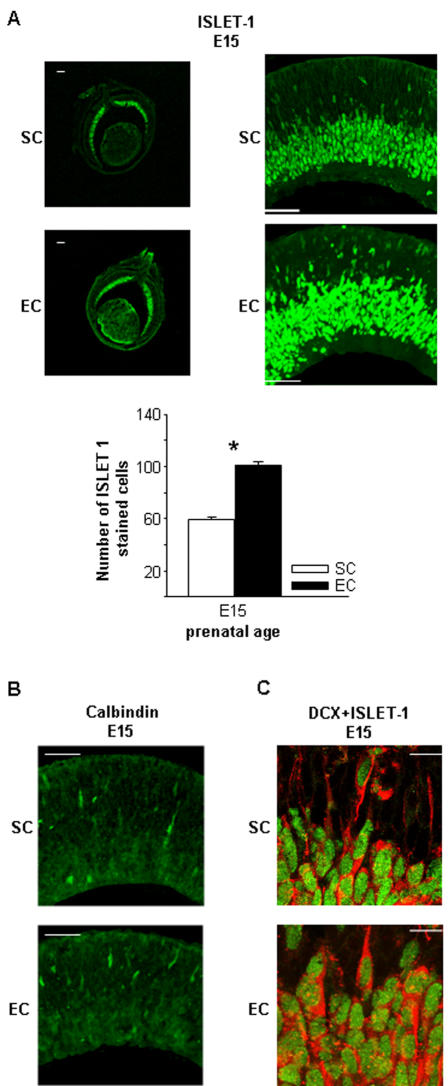
Identification of specific cell types involved in the accelerated migration of retinal cells in EC fetuses.(A, top) Micrographs of EC and SC retinal sections immunostained for ISLET-1 (a marker for ganglion and cholinergic amacrine cells) at E15, acquired at 5× (left, scale bar: 100 µm) or 20× (right, scale bar: 50 µm). (A, bottom) Number of cells stained for ISLET-1 in the outer retinal layers of SC and EC rats. The number of ISLET-1-labeled cells was higher in EC than in SC embryos (t-test, p<0.001). Bars indicate s.e.m. (B) Micrographs of EC and SC retinal sections immunostained for calbindin (a marker for horizontal cells) at E15, acquired at 20× (scale bar: 50 µm). The number of calbindin-labeled cells did not differ between EC and SC embryos (t-test, p = 0.253). (C) Micrographs of EC and SC retinal sections co-immunostained for DCX (red) and ISLET-1 (green) at E15, acquired at 60x. Scale bar: 10 µm.